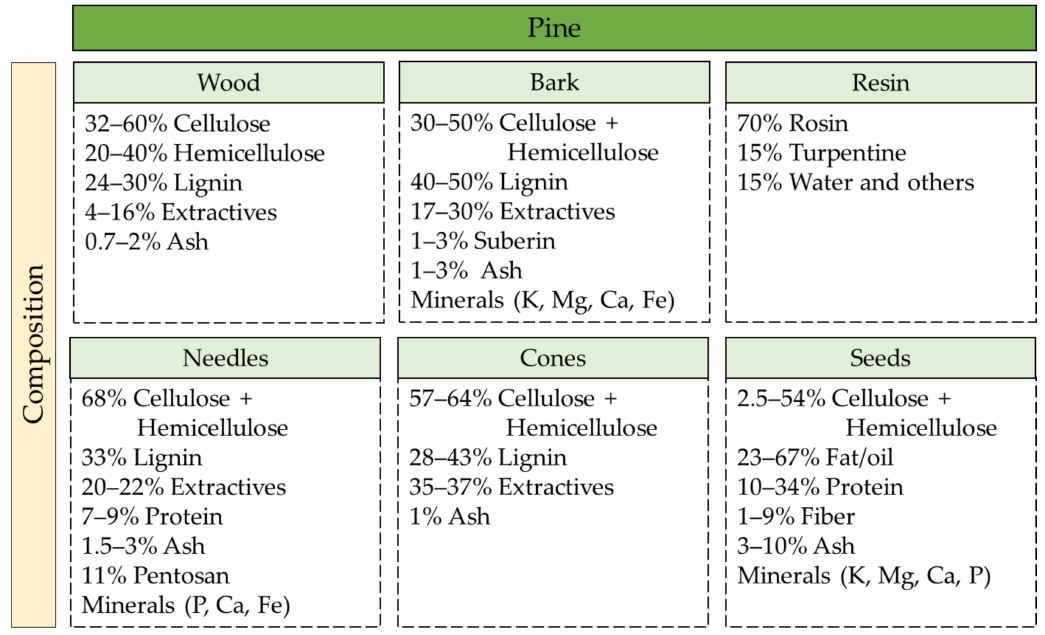
Figure 2. General chemical / nutritional composition of pine